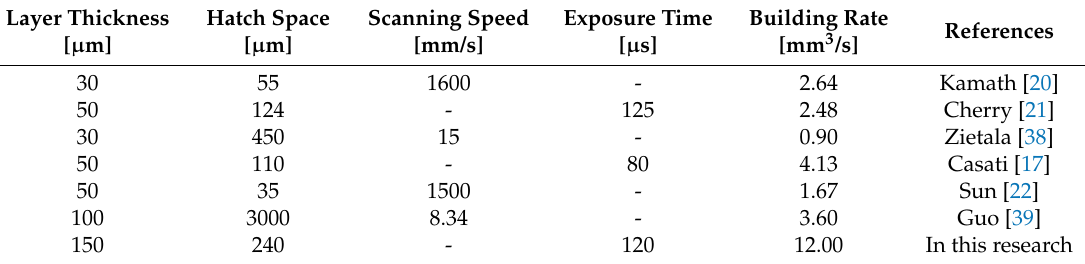
Table 5. Summary of the building rate with previous